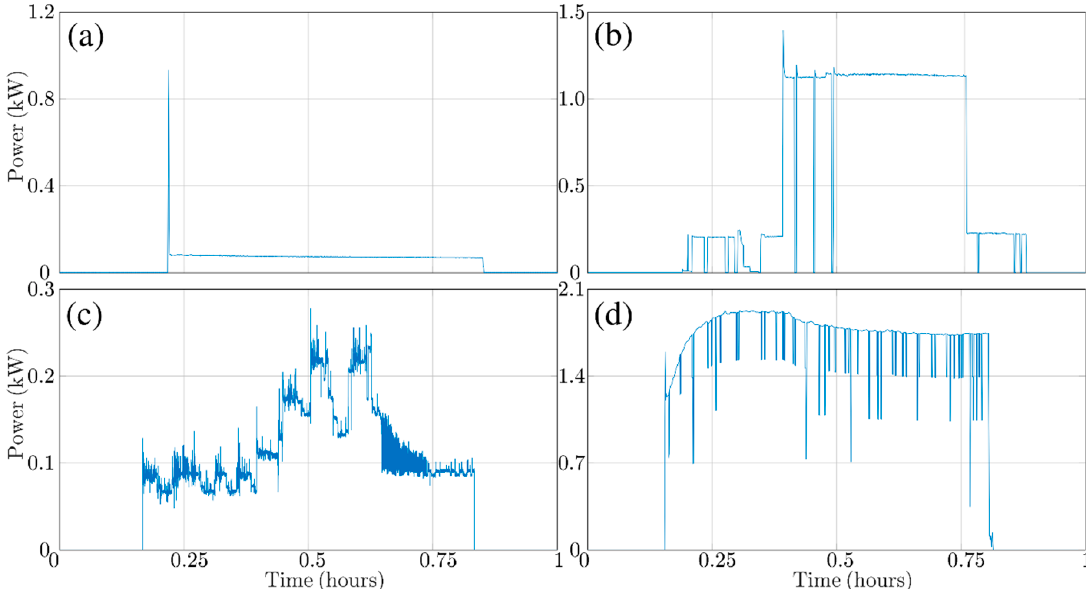
Figure 3. Examples of appliance signatures for ( a ) one-state appliance with significant peak (refrigerator), ( b ) multi-state appliance without significant peak (dishwasher), ( c ) nonlinear appliance (laptop), and ( d ) continuous appliance with decay (air- conditioning) from the REDD database.